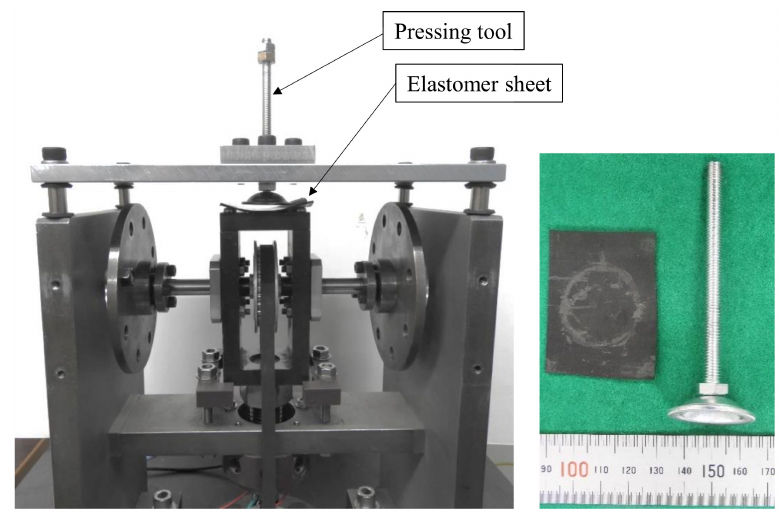
Figure 6. Pressing tool to suppress overload on the